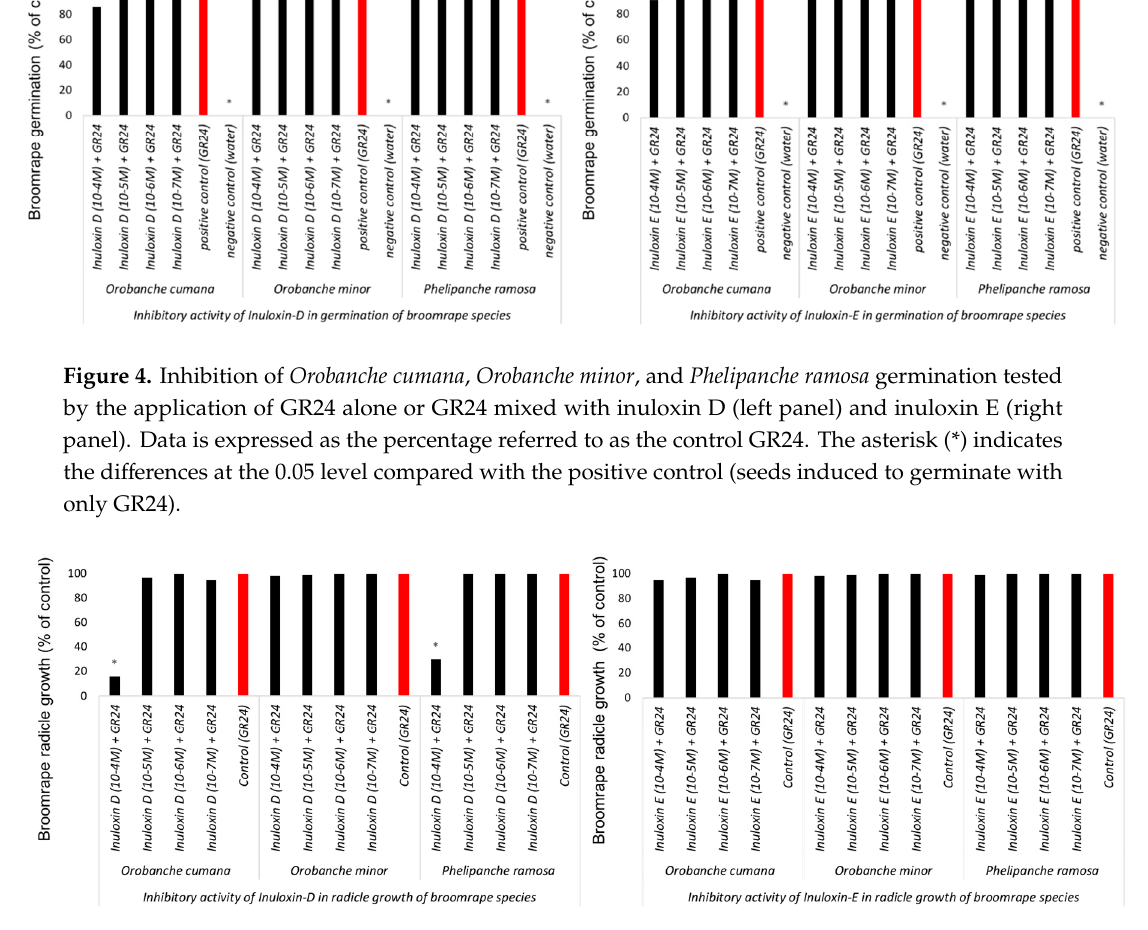
Figure 5. Orobanche cumana , Orobanche minor , and Phelipanche ramosa radicle growth in the presence of GR24 alone or GR24 mixed with inuloxin D (left panel) and inuloxin E (right panel). Data is expressed as the percentage referred to as the control GR24. The asterisk (*) indicates the differences at the 0.05 level compared with the positive control (GR24).